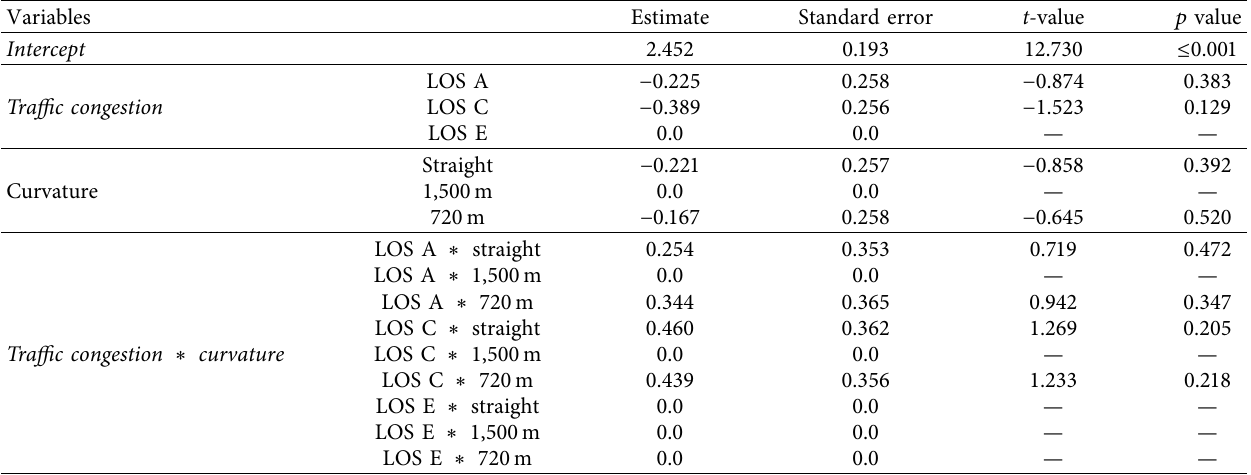
Table 4: Estimated takeover time from LMM by LOS and curvature.